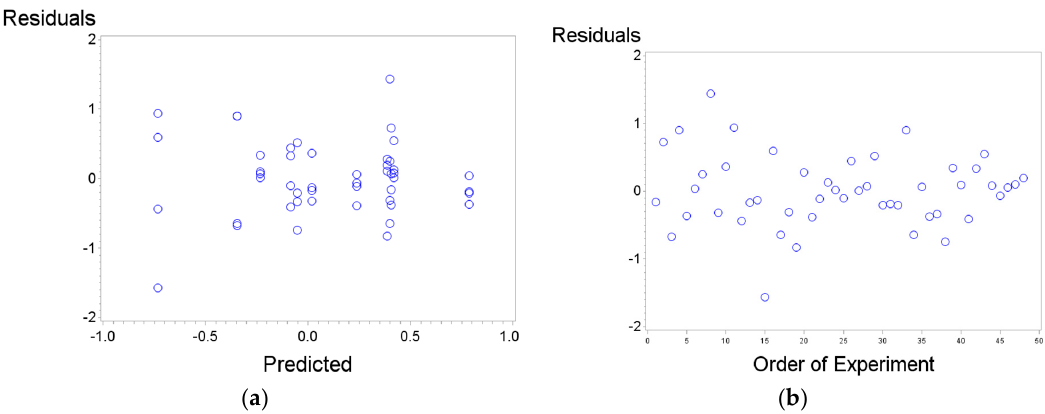
Figure 11. ( a ) Checking the homoscedasticity hypothesis for residuals; ( b ) Checking the nonexistence of special patterns on residuals.